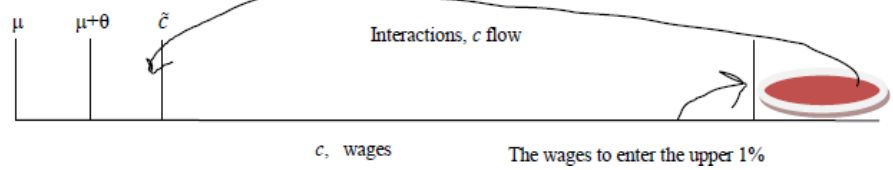
Fig. 4. The representation of the wages c , the society's fractions, and the interaction ¯gure. Here the wealth to enter the top 1% is just ¯ve times the average